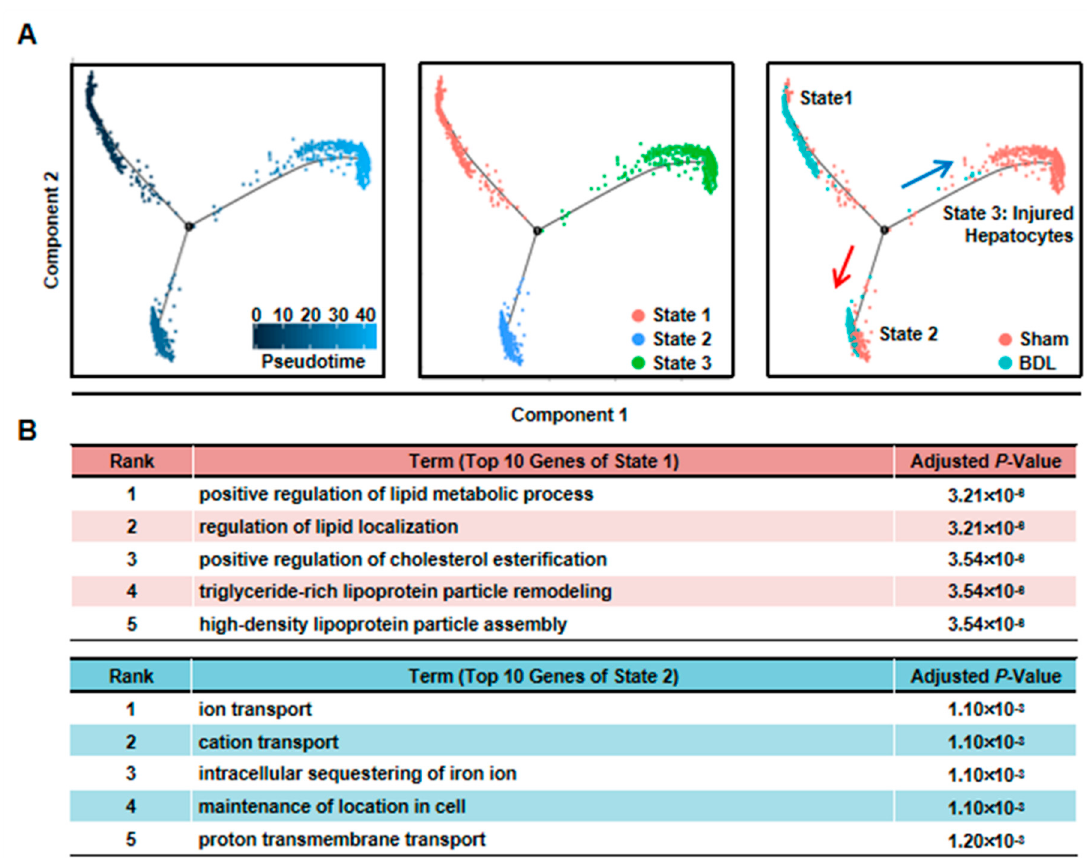
Figure 3. Pseudotime analysis indicated hepatocyte function transformation during liver injury. ( A ) Pseudotime analysis of hepatocytes was performed in the mixed cells. ( B ) GO analysis of top 10 genes of State 1 and State 2.